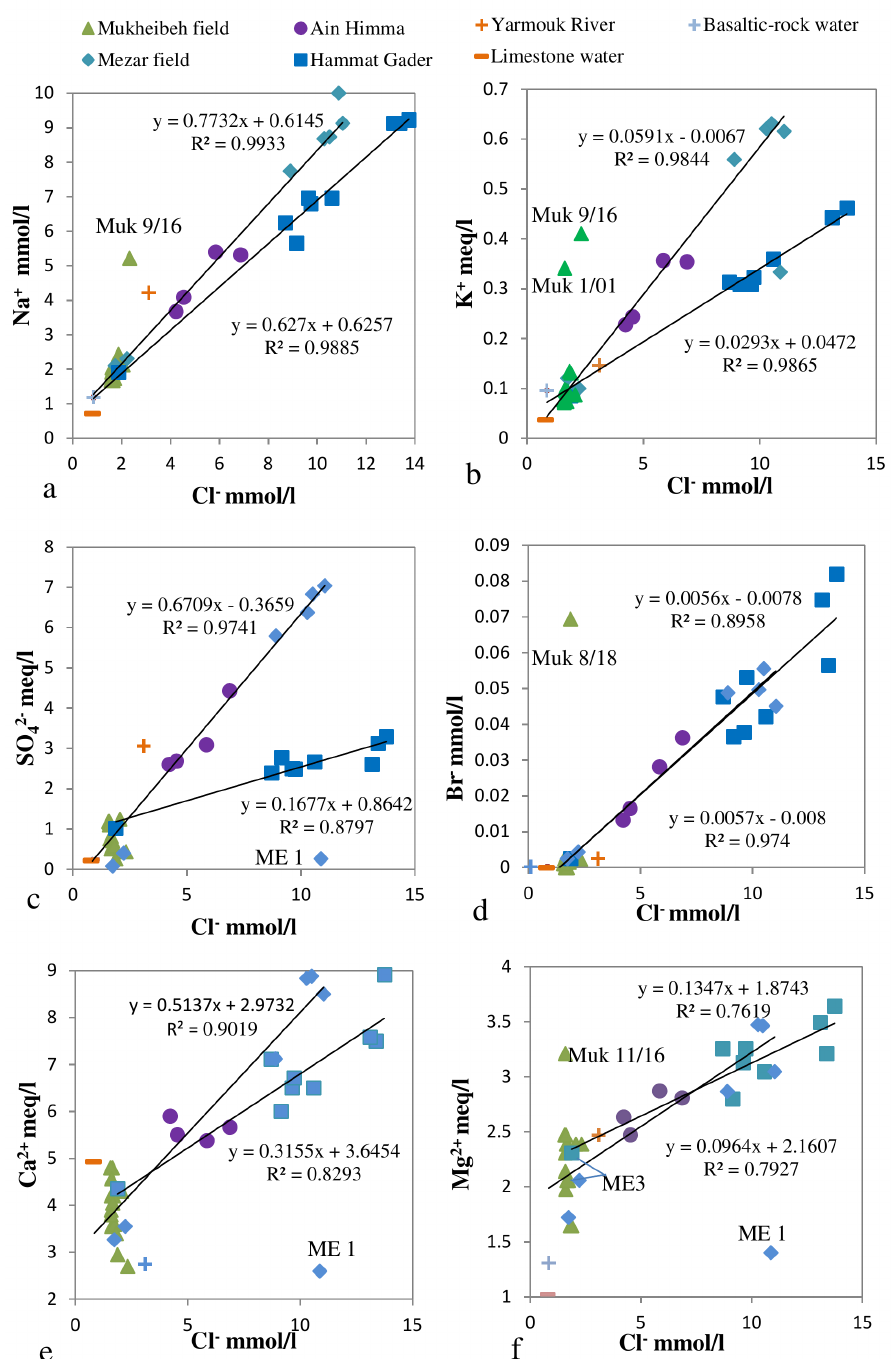
Figure 5. Cross plots of dissolved species in groundwater. Note that the high-salinity groundwaters are related to either basaltic or limestone water ( a – e ). This is not the case in ( f ). Averages of low-Cl − -containing water from the Ajloun Mountains and from the Golan Heights are used for limestone water. Averages of low- Cl − -containing water from the Hauran Plateau are used for basaltic-rock water (code names are explained in Table 1). x/yy indicates the sampling ID and the year of sampling in the 21th century. Regression lines and R 2 are estimated with Microsoft excel